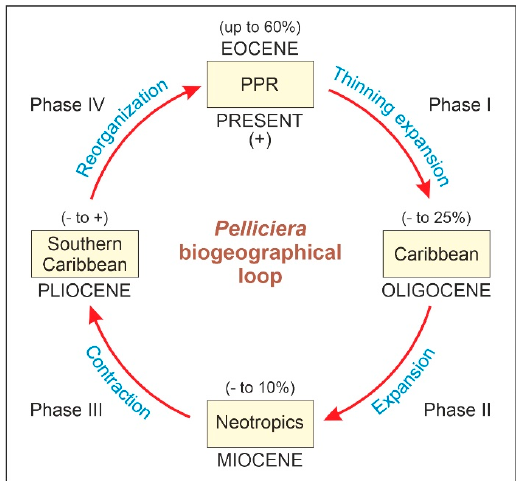
Figure 5. Diagram of the Pelliciera biographical loop with indication of the ranges of abundance of its fossil pollen in each geological epoch. PPR, present Pelliciera range.